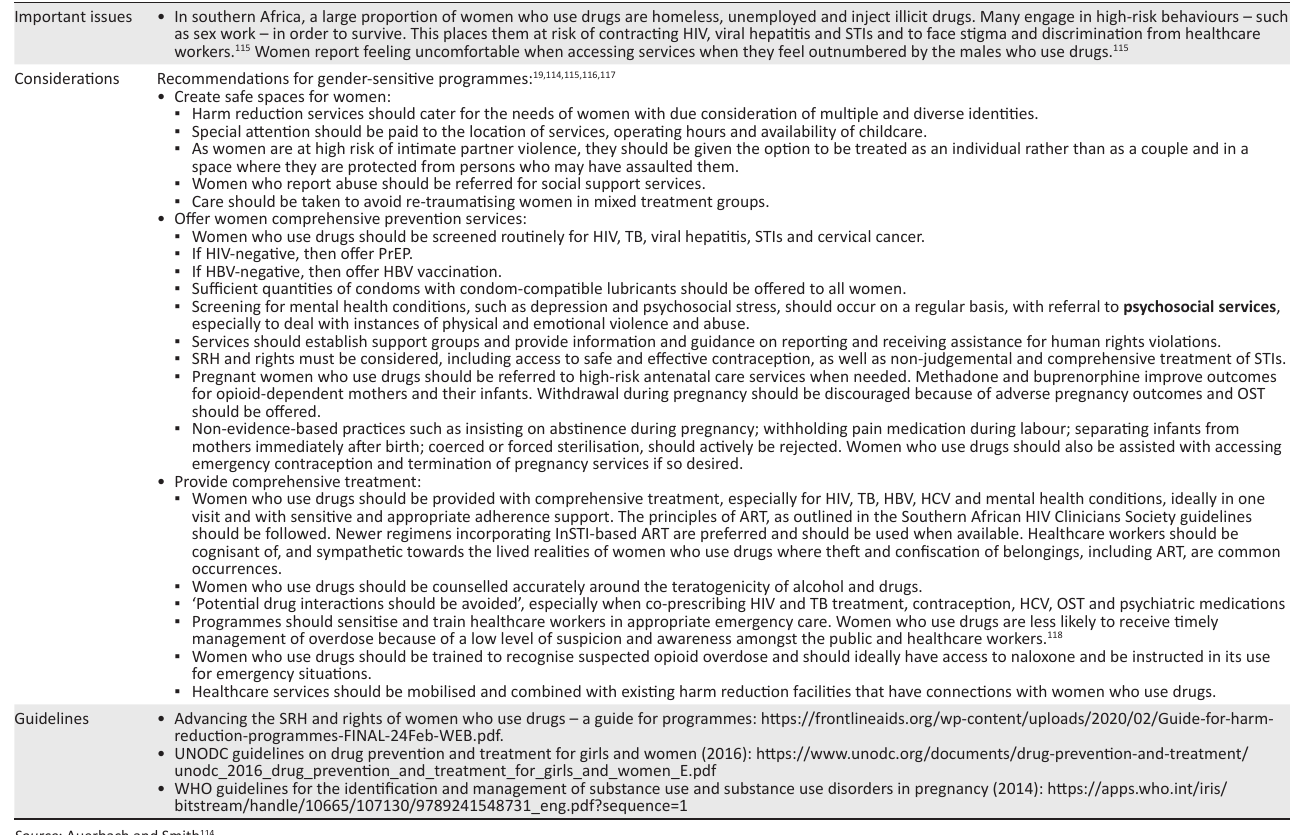
TABLE 26: Women who use drugs. Variable